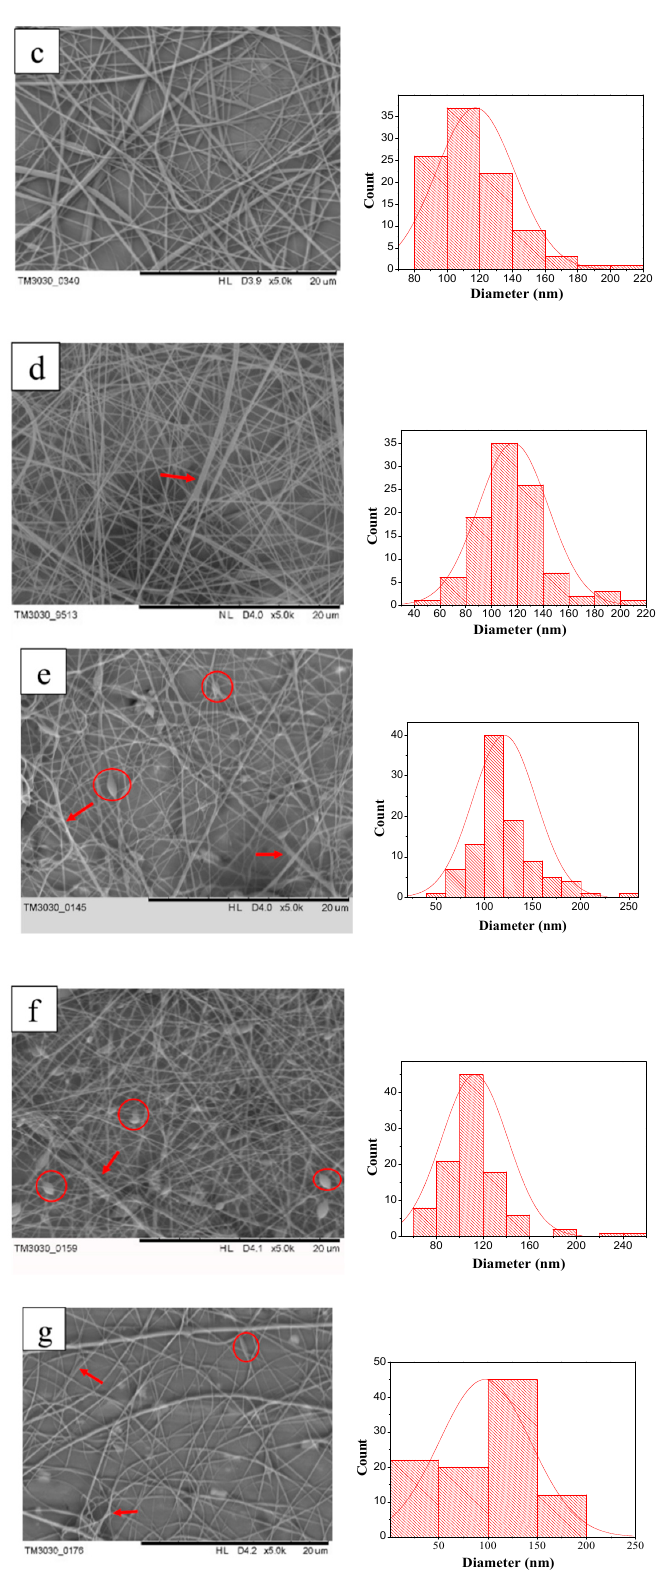
Figure 2. SEM images and corresponding diameter distribution of Polyvinyl alcohol/graphene (PVA/GR) nanofiber films made of 7.5 wt % PVA solution and ( a ) 0, ( b ) 0.01, ( c ) 0.1, ( d ) 0.25, ( e ) 0.5, ( f ) 1, and ( g ) 2 wt % graphene. The coalesced nanofibers and bead-shaped nanofibers are indicated in red arrows and by red circles, respectively. GR: graphene.